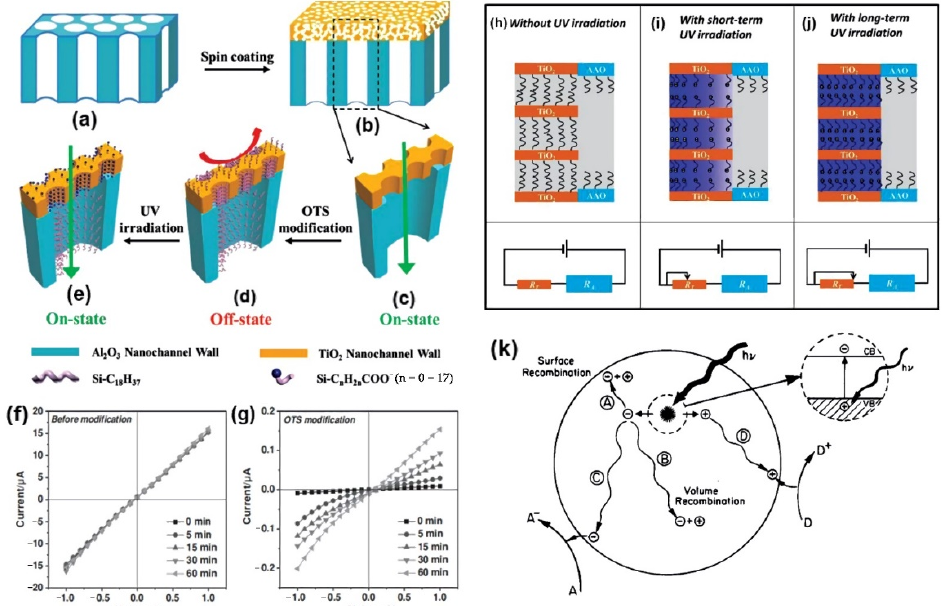
Figure 6. TiO 2 -Al 2 O 3 heterogeneous nanochannels for ion rectification. ( a ) Al 2 O 3 porous structure. ( b ) TiO 2 porous coating deposited on Al 2 O 3 porous structure. ( c ) Magnified TiO 2 -Al 2 O 3 heterogeneous nanochannels. ( d ) Octadecyltrimethoxysilane (OTS) molecules were modified on the TiO 2 /Al 2 O 3 nanochannels, which showed superhydrophobic properties. ( e ) After UV irradiation, part of the TiO 2 nanochannels became hydrophilic. ( f , g ) Image of the I–V property of TiO 2 /Al 2 O 3 nanochannels by OTS modified/unmodified UV irradiation on TiO 2 . Reprint from [37]. ( h ) Fewer decomposed organic anions formed and smaller ion currents appeared without UV irradiation. ( i ) Some decomposed organic anions formed and normal ion currents appeared with short-term UV irradiation. ( j ) More decomposed organic anions formed and larger ion currents sappeared with long-term UV irradiation. Copyright (2014), with permission from WILEY-VCH, Weinheim, Germany. ( k ) Schematic diagram of photoexcited electron transition. Reprint from [100]. Copyright (1995), with permission from American Chemical Society, Washington, DC.